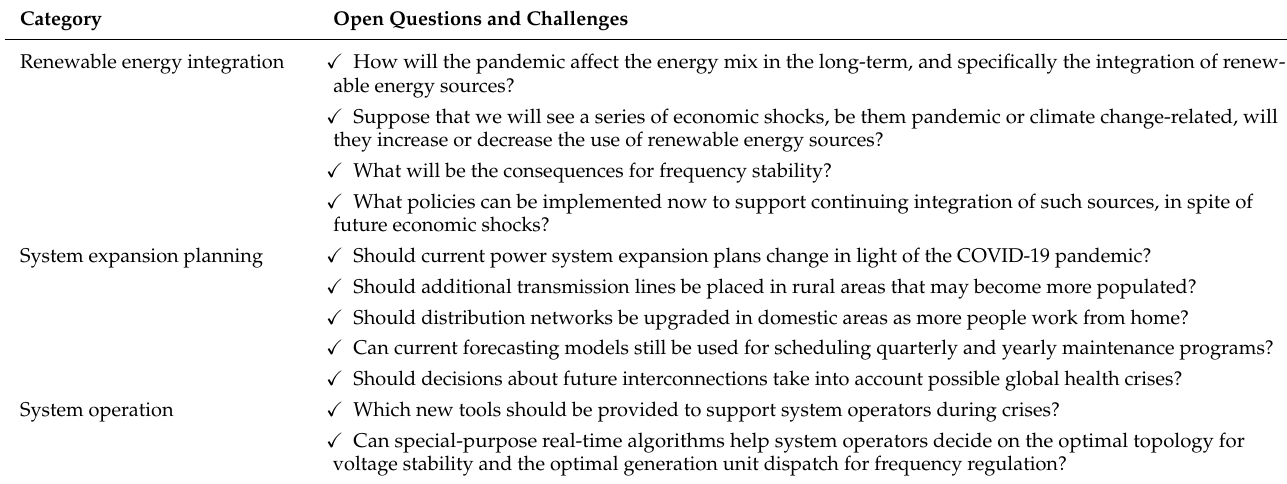
Table 6. Summary of open questions and